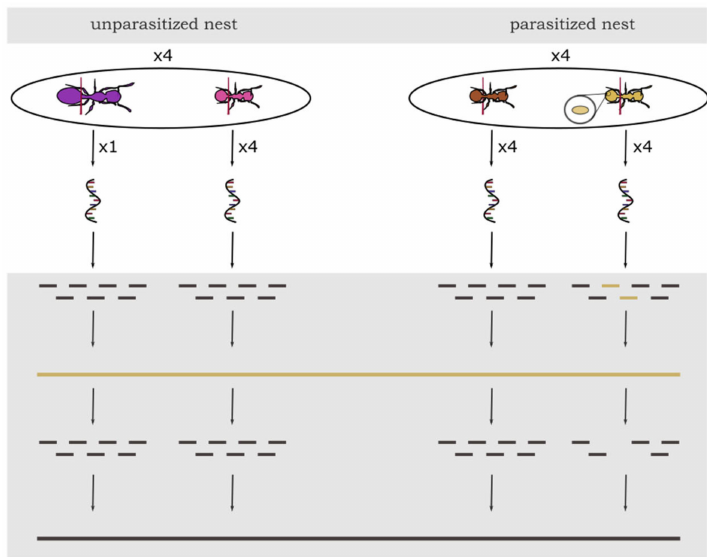
Figure 1. Experimental design of sampling and schematic analysis of gene expression data in T. nylanderi ants with different caste (workers or queens) and infection status. From each of the four unparasitized nests (left side) four workers were pooled per colony. Queen samples from unparasitized colonies consisted of only one individual. From each of the four parasitized nests (right side) four uninfected workers and four infected workers were pooled into two separate samples. Bottom grey part represents bioinformatic workflow: After sequencing, all samples were filtered for cestode RNA and other putative contaminants (yellow) and afterwards, all ant sequences were mapped against the genome of T. nylanderi for further analyses